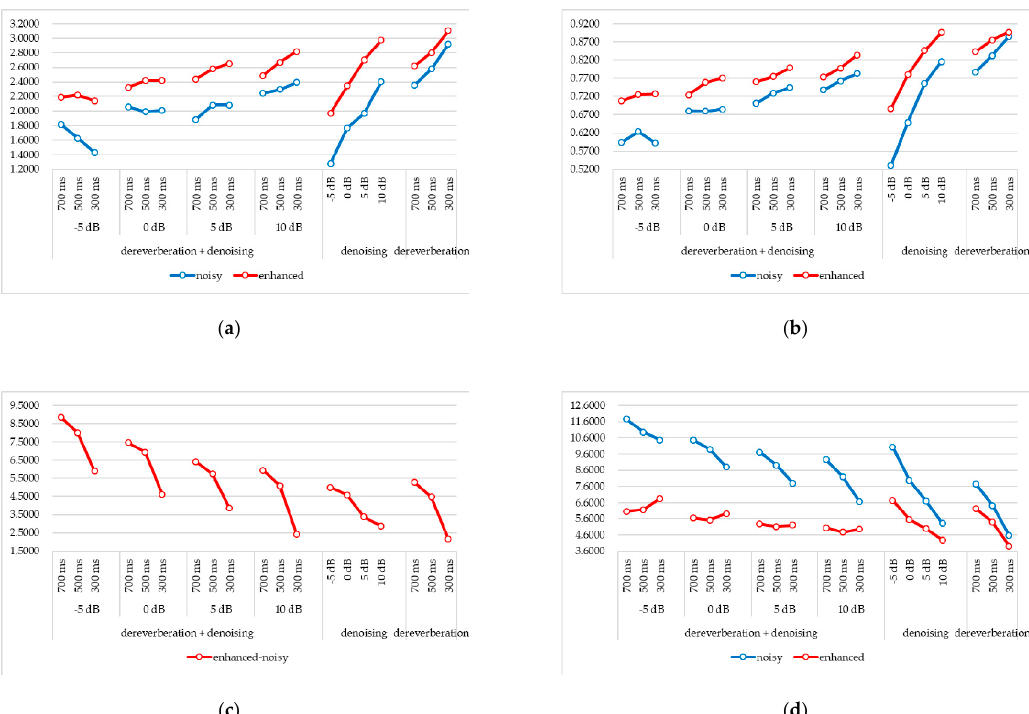
Figure 14. The average evaluation results of multi-channel speech enhancement. ( a ) PESQ results; ( b ) STOI results; ( c ) SSNR improvement results; ( d ) LSD results.